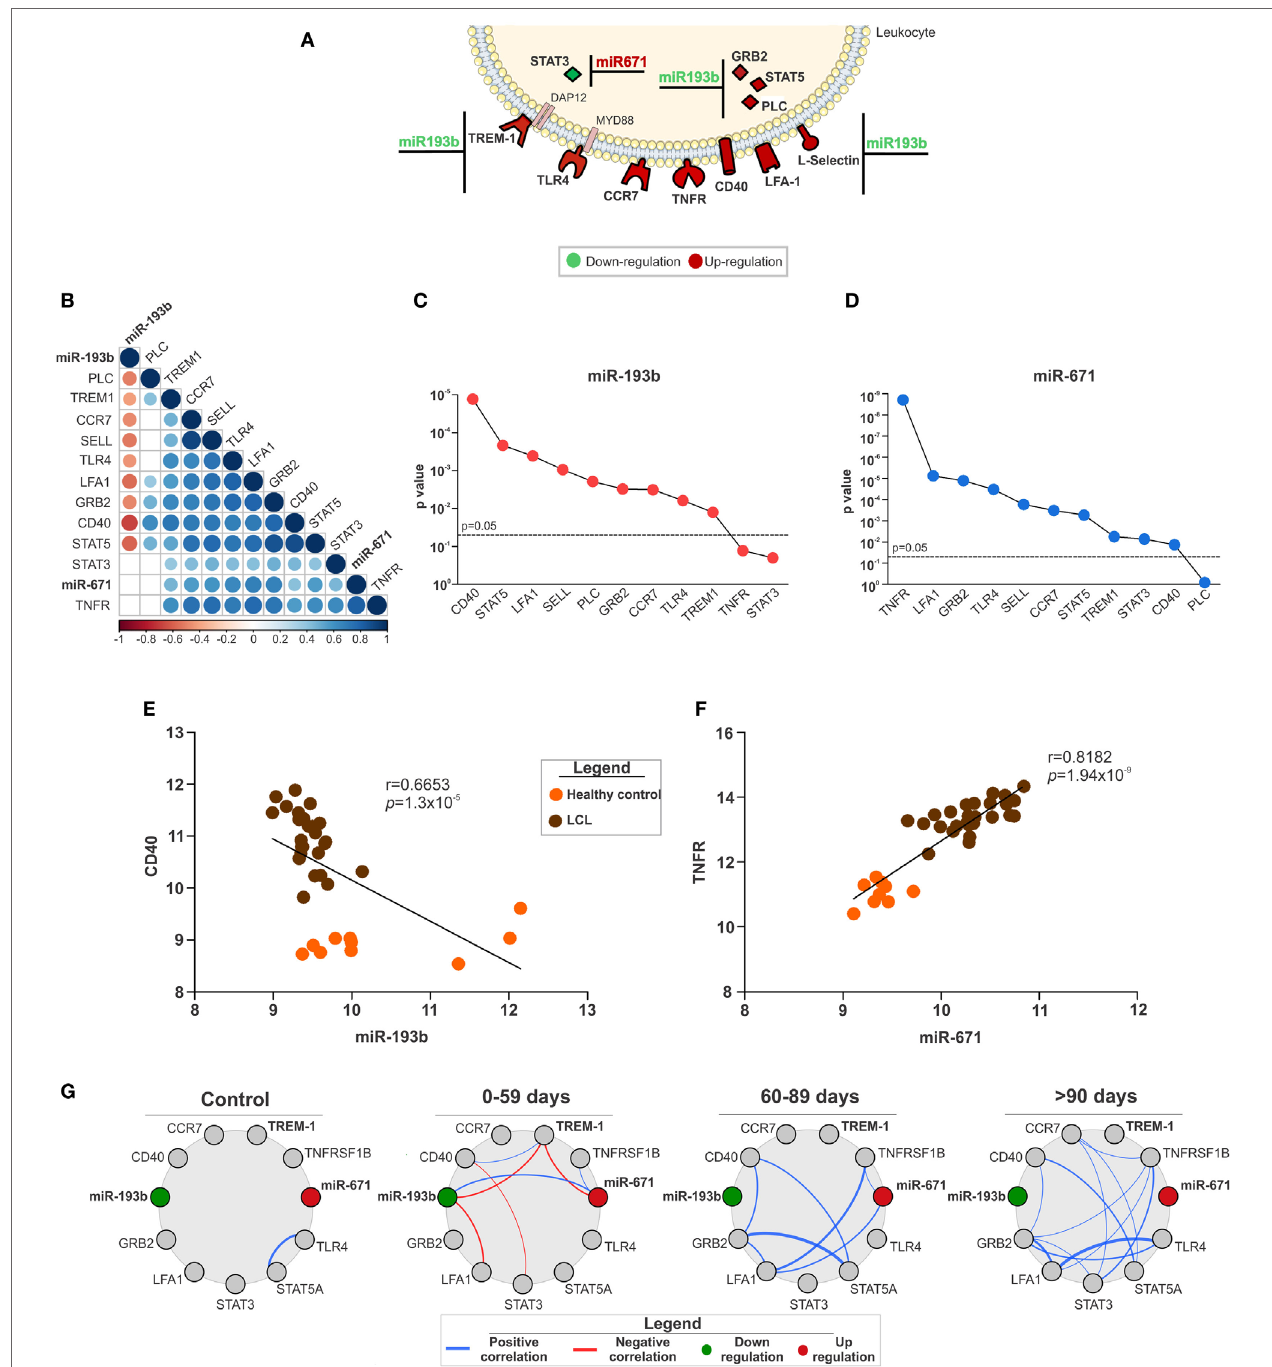
FigUre 4 | The expression of miR-193b and -671 and their target genes as key in localized cutaneous leishmaniasis (LCL) outcome. (a) Representative image of molecules from innate immune response pathways and their respective microRNAs with opposite expression ( ↑ miR ↓ target or ↓ miR ↑ target). (B) Correlation matrix between the expression of microRNAs and their target genes. Circles and corresponding sizes represent significance ( p < 0.05) and r -values for each Spearman correlation, respectively. Colors represent the directionality of the correlation (blue infers positive correlation, whereas red indicates negative correlations). (c) p -Values of negative Spearman correlations between miR-193b and the indicated target genes are shown. (D) p -Values of positive Spearman correlations between miR-671 and the indicated target genes are described. Spearman correlations between (e) miR-193b/CD40 and (F) miR-671/TNFR. (g) Network analysis shows Spearman correlations ( − 0.6 < r > 0.6) between microRNAs and target genes according to the response to treatment (cured by 59, 60–89 or > 90 days). Colors represent the directionality of the correlation (red line, negative correlation and blue line, positive correlation; red circles, upregulated and green circles, downregulated